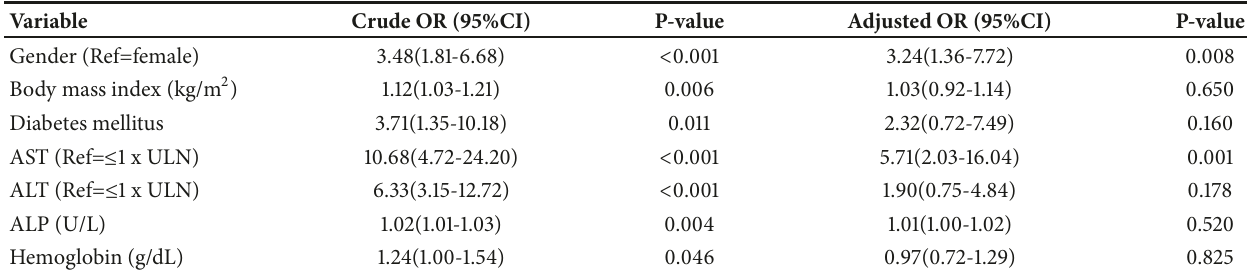
Table 4: Multivariable logistic regression analysis on factors associated with significant fibrosis